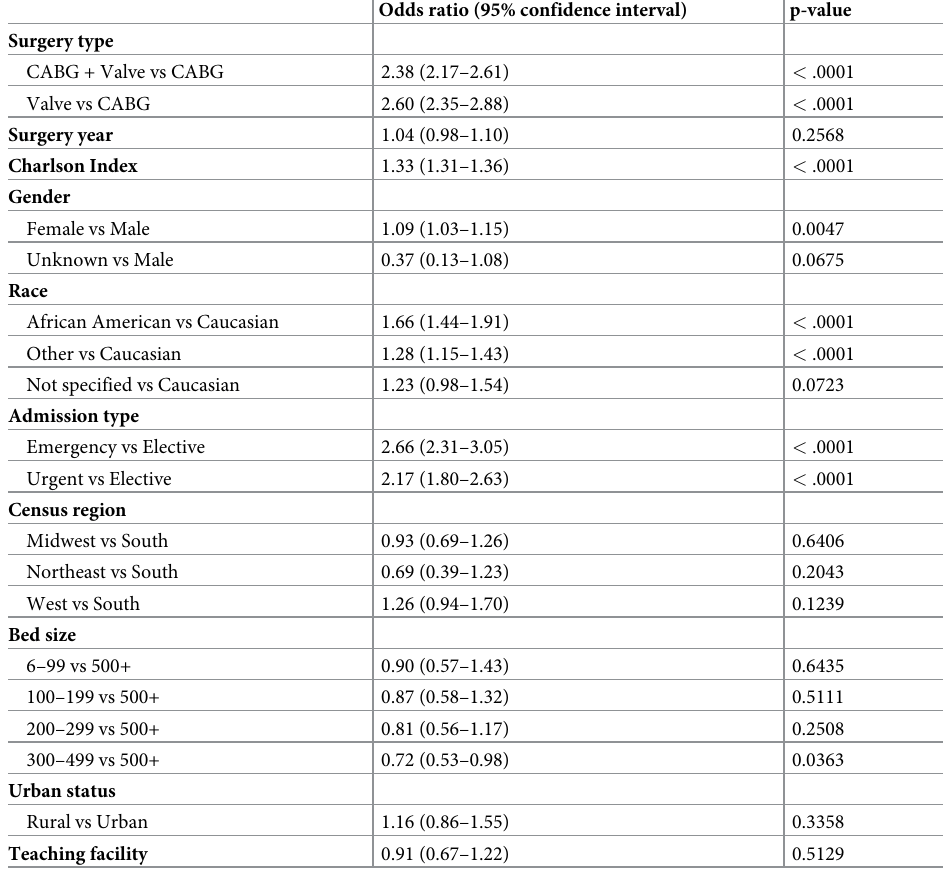
Table 2. Logistic regression model results for heart failure cohort at index visit (n =